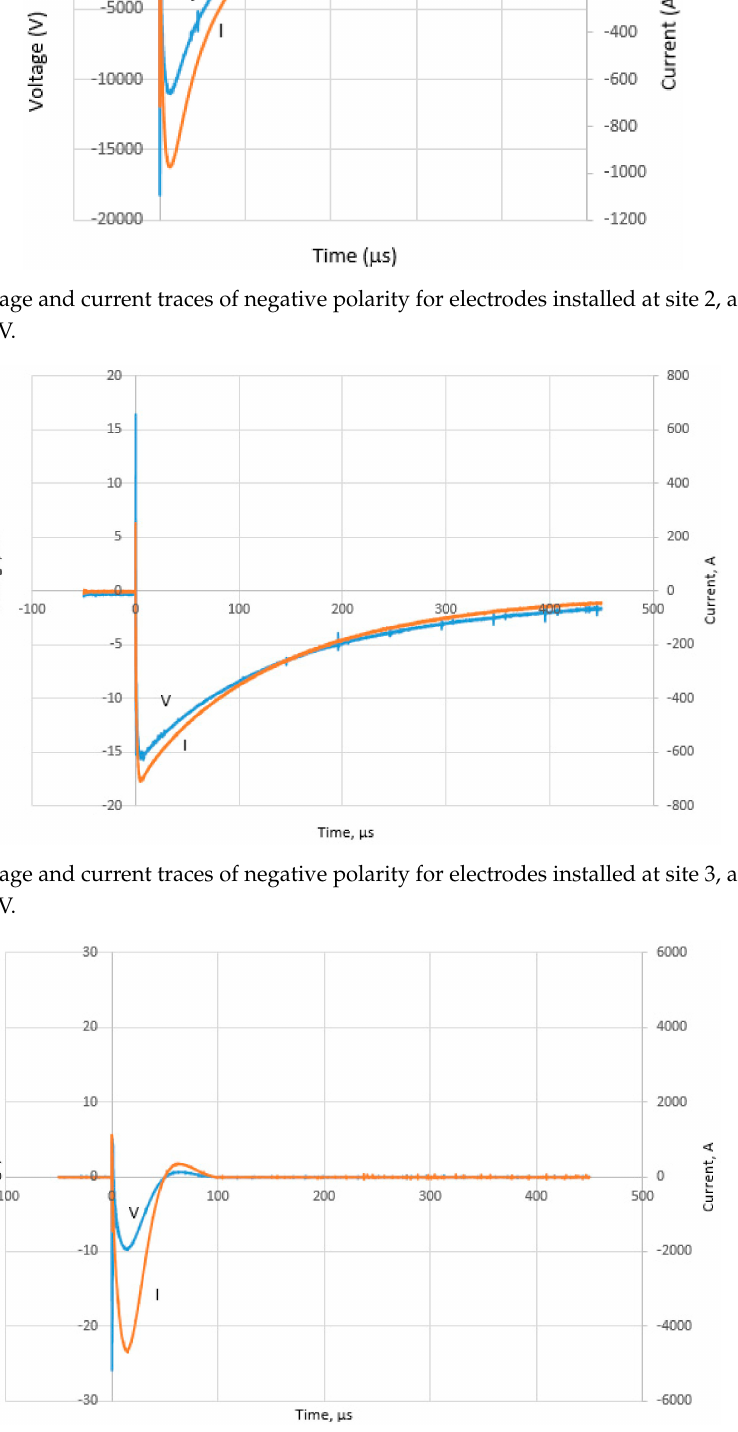
Figure 17. Voltage and current traces of negative polarity for electrodes installed at site 4, at a charging voltage of 30